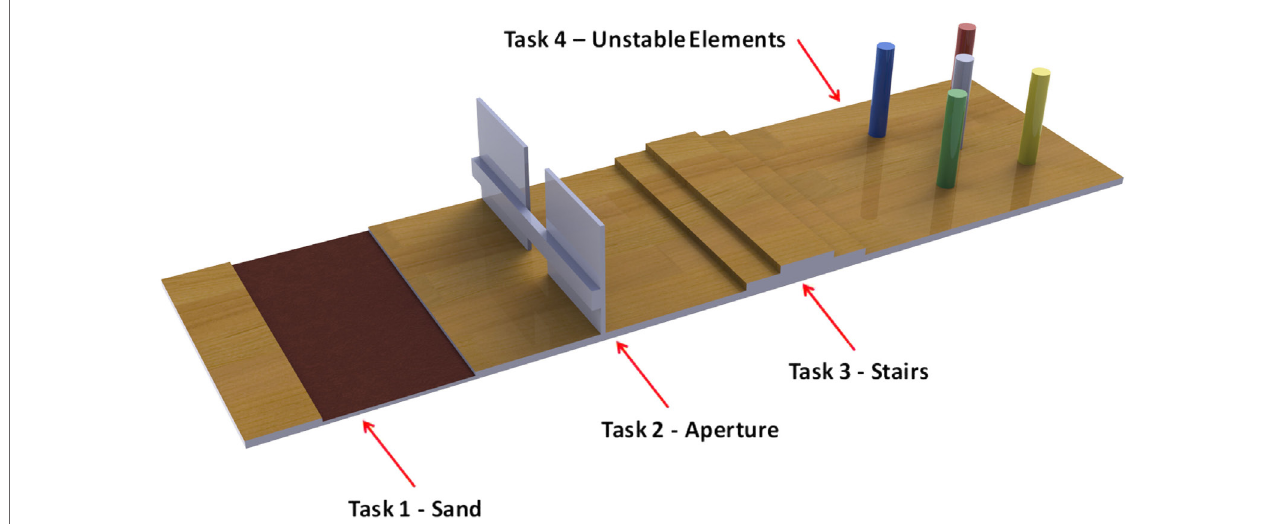
FigUre 1 | The tasks defined by the grand challenge for the terrestrial race: to start with a sandy ground, followed by a gate, then with three steps of stairs and finish with obstacles of unstable elements .